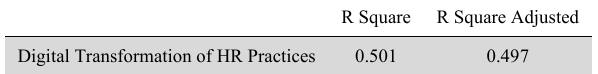
Quality of Model